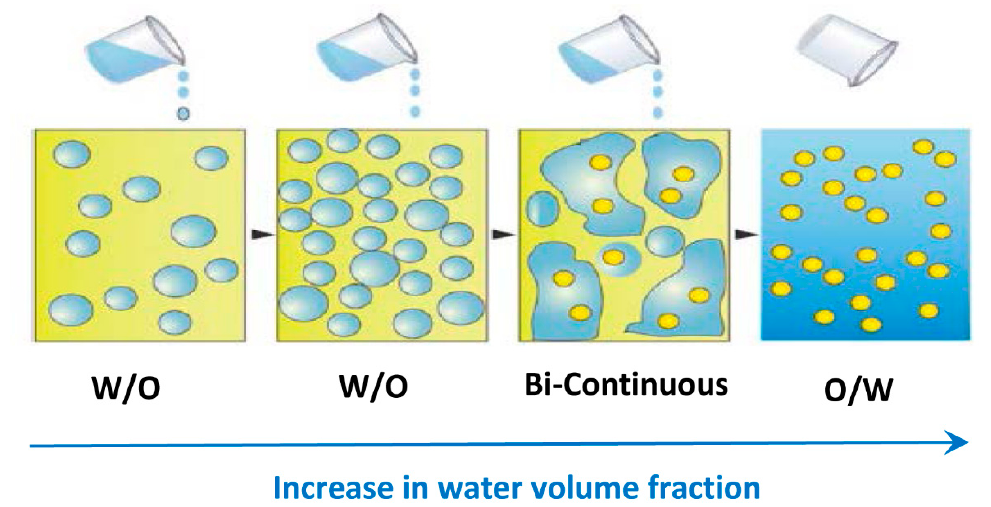
Figure 9. Catastrophic phase inversion of W / O emulsion to O / W emulsion (adapted from [23]).